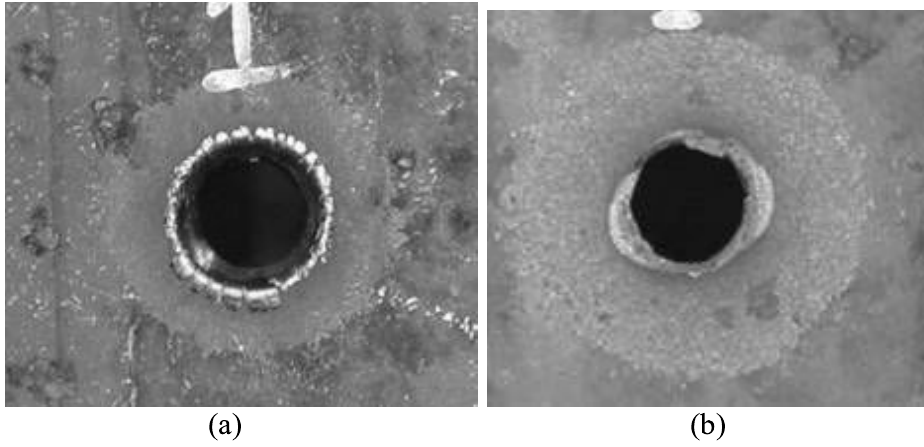
Fig. 11. 12.7 mm plate failure modes (a) piercing impact, and (b) plugging exit.